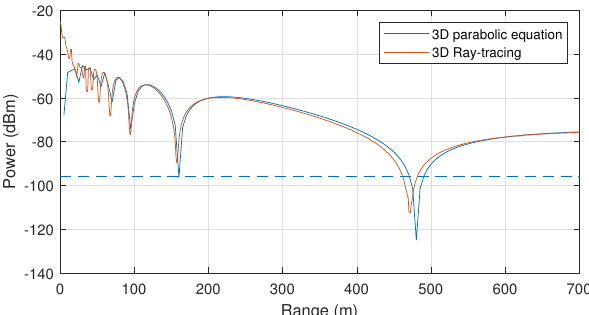
Figure 1. Propagation without obstacles. Distribution of the signal level at the height of 1.5 above the ground.